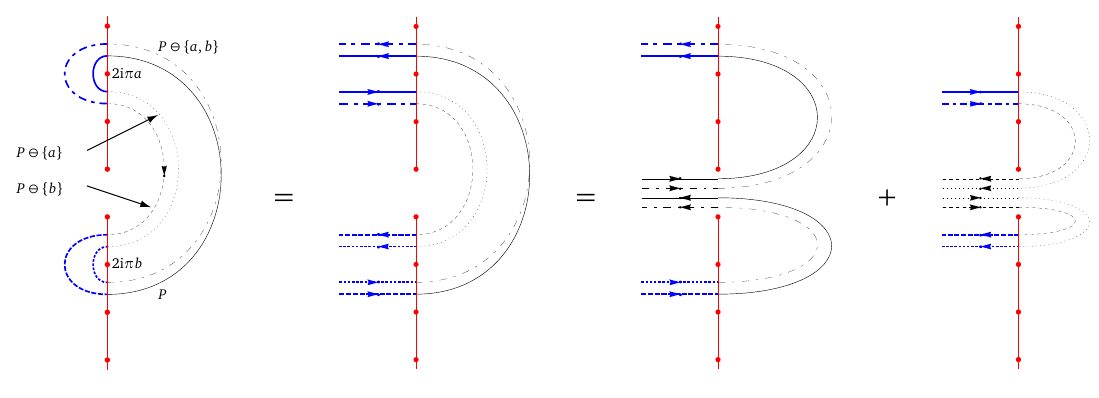
· P , b < 0 < a in terms of paths of the form a , b are represented P